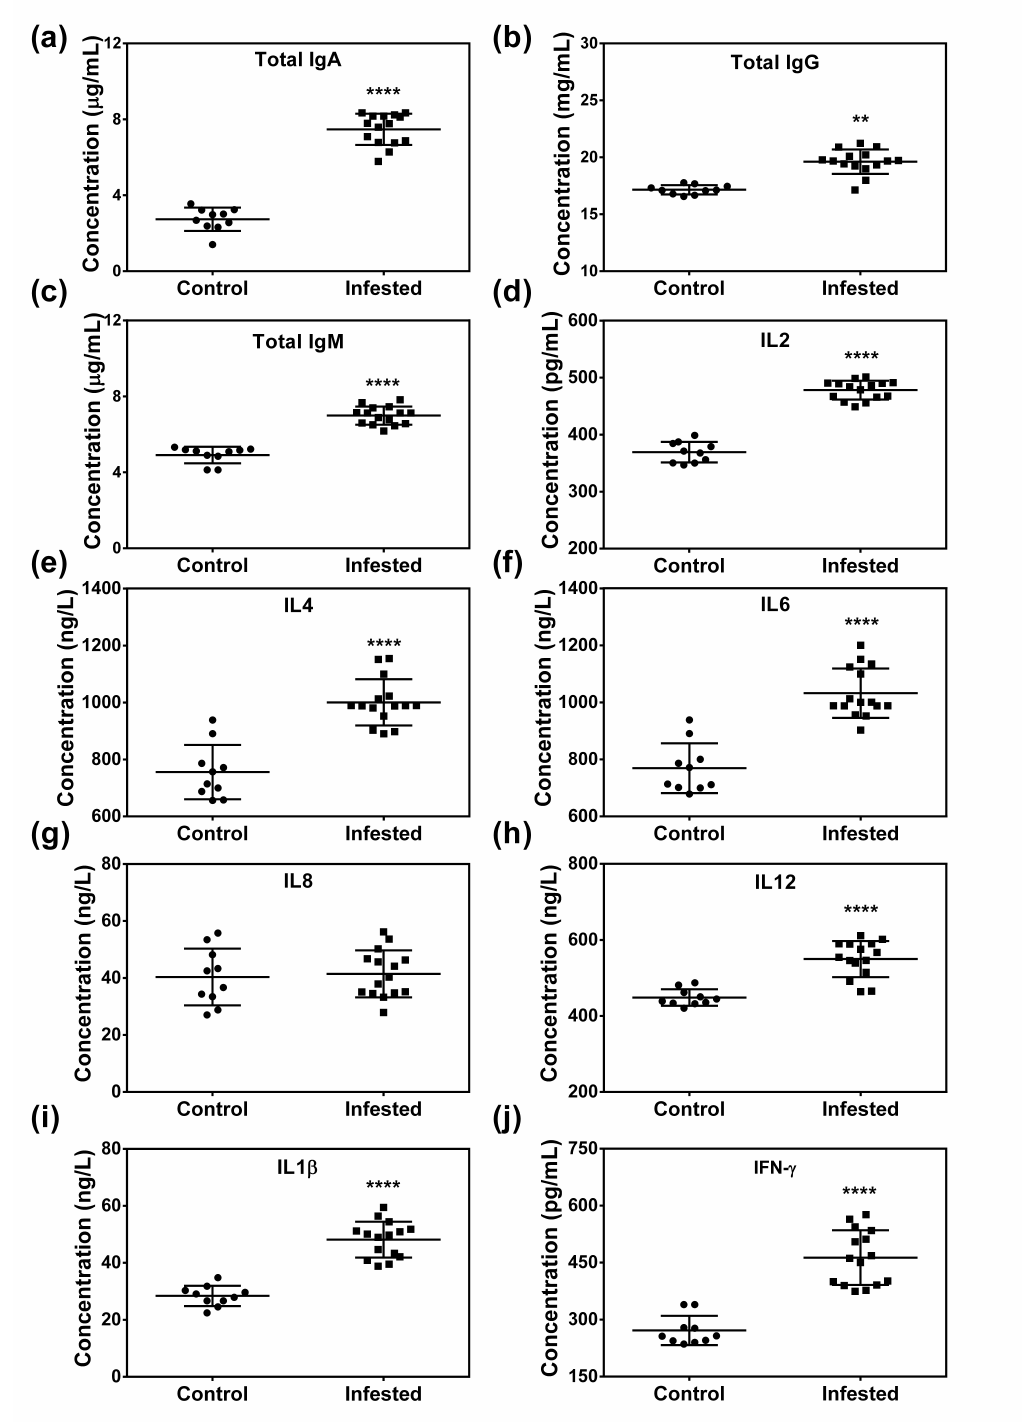
Figure 9. E ff ect of crusted scabieson total serum immunoglobulins and cytokine response in a porcine model. ( a ) Total IgA, ( b ) total IgG, ( c ) total IgM, ( d ) IL-2, ( e ) IL-4, ( f ) IL-6, ( g ) IL-8, ( h ) IL-12, ( i ) IL-1 β , and ( j ) IFN- γ . Data in scatter plot are shown as mean ± SD. t -test was performed to find out significant di ff erence between the two groups. ** denotes p ≤ 0.01, **** denotes p ≤